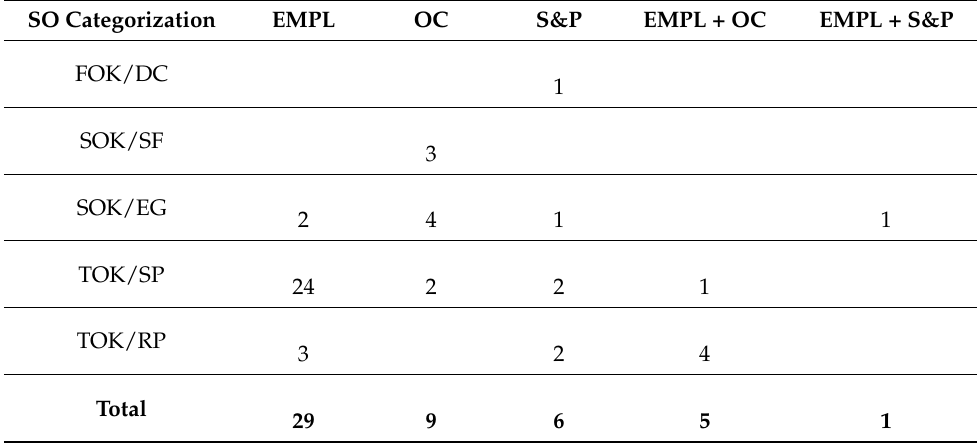
Figure 3. Mapping the categorical discussion. Table 2. Hospitality and tourism SO knowledge